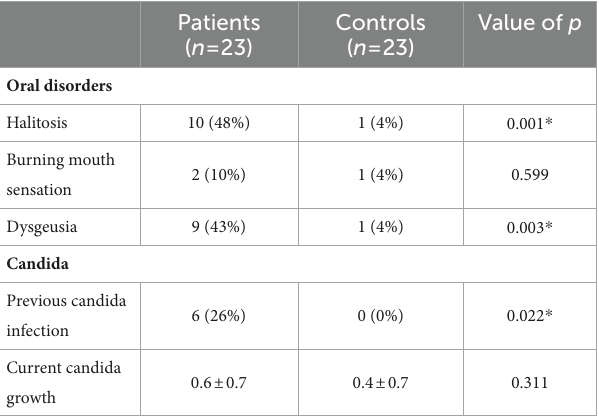
TABLE 8 Frequency of complaints about halitosis, burning mouth sensation and dysgeusia, and previous and current oral candida infection.